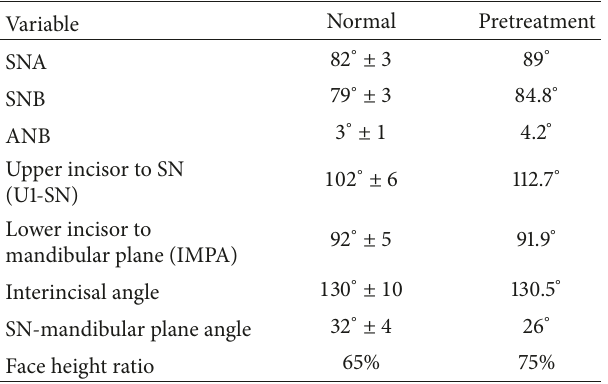
Figure 3: Pretreatment lateral cephalometric image.